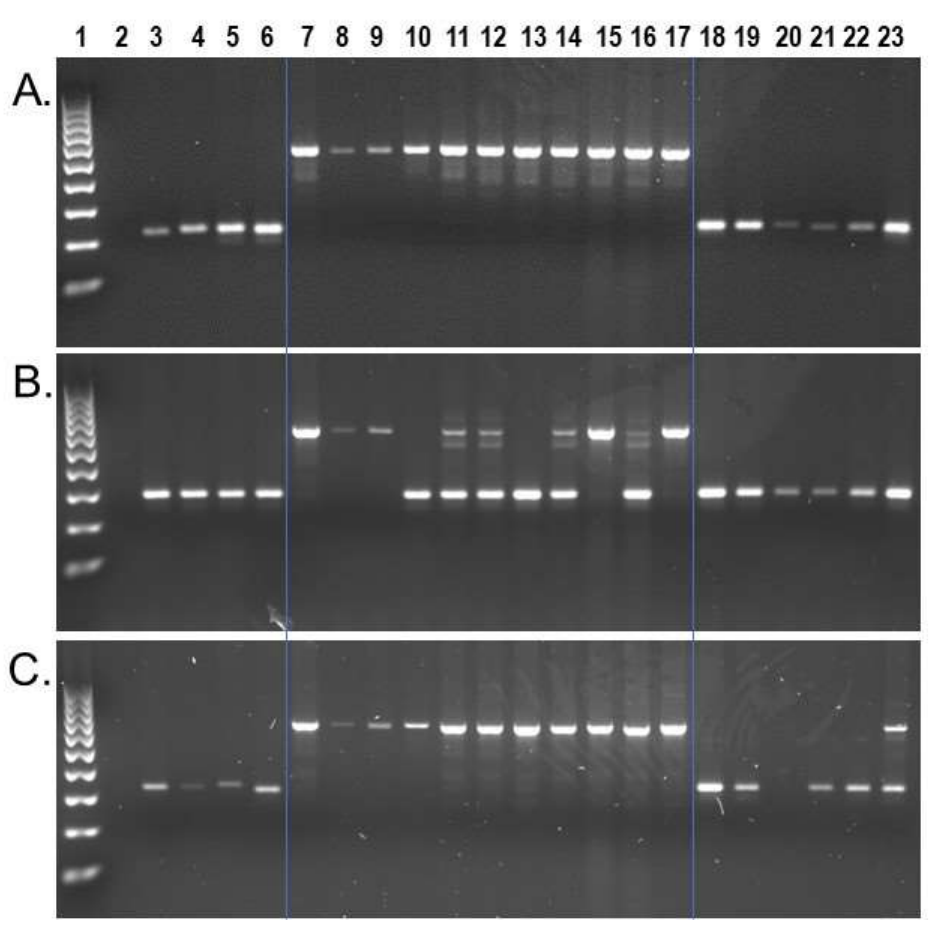
Figure 3. S. apella genomic Alu insertion polymorphisms. Lanes: 1 100 bp DNA ladder, 2 TLE (negative control), 3 Human (HeLa), 4 C. jacchus (Common marmoset), 5 S. s. sciureus (Common squirrel monkey), 6 A. trivirgatus (Three striped owl monkey), 7–17 S. apella, 18 C. imitator , 19–20 C. capucinus , 21–22 C. albifrons , 23 C. a. albifrons . ( A ) Locus # 984.99, the Alu element is present in all Sapajus individuals (~528 bp) and absent in all Cebus samples (~227 bp fragment); ( B ) Locus #978.25, the Alu element is polymorphic among Sapajus individuals (~604 bp and ~292 bp DNA fragments) and absent in Cebus samples; ( C ) Locus #944.49, the Alu element is present in all Sapajus individuals (~671 bp fragment), and heterozygous present (~671 bp and ~341 bp DNA fragments) in individual KB-4207, C. a. albifrons . Blue lines superimposed on gel images visually separate Cebus , Sapajus and outgroups.